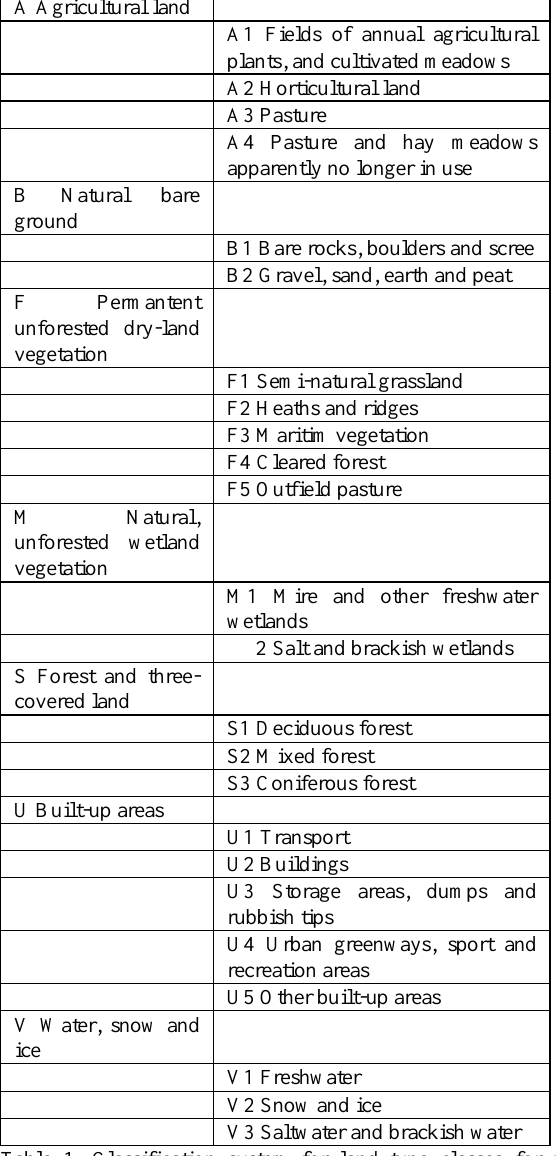
Table 1. Classification system for land type classes for the Norwegian land use / land cover monitoring program.